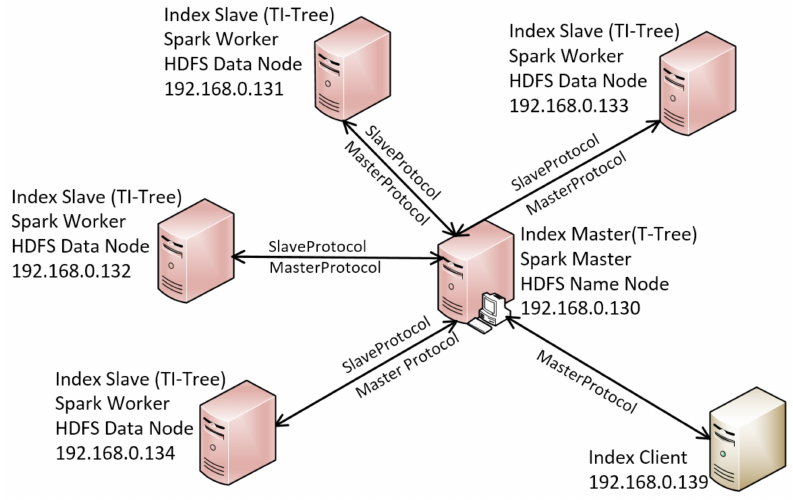
Figure 12. Architecture of the experimental